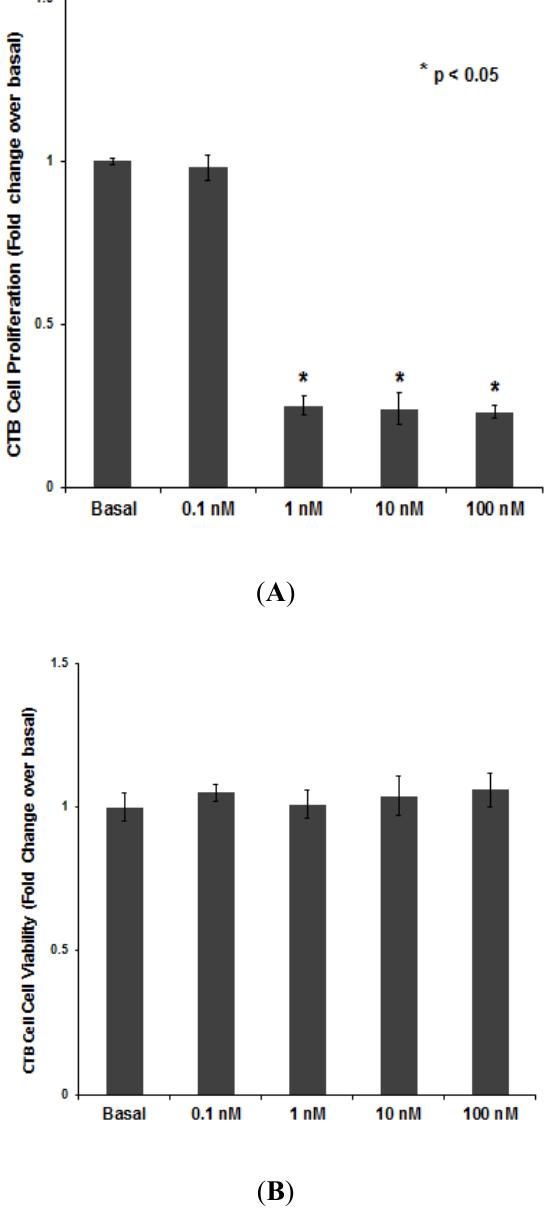
Figure 2. CTB cells were treated with different concentrations of PNTTU and ( A ) Proliferation, ( B ) Cell Viability, and ( C ) Migration were measured. PNTTU significantly ( * p < 0.05) downregulated the proliferation and migration in CTB cells and had no effect on cell viability. The data are presented as mean ± SEM for four